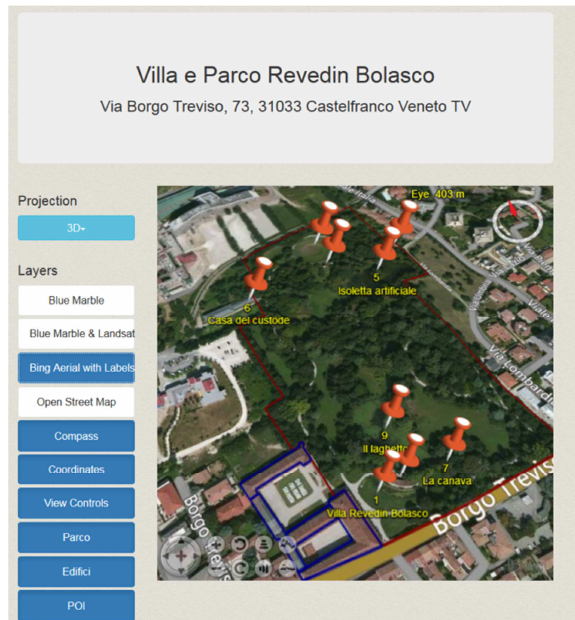
Figure 11. Point of interest displayed as Web World Wind placemark.